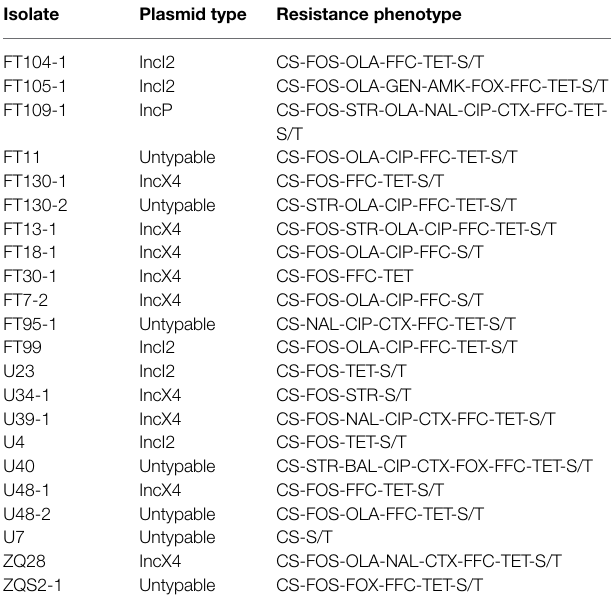
TABLE 1 | Bacterial information and antimicrobial resistance profiles. Isolate Plasmid